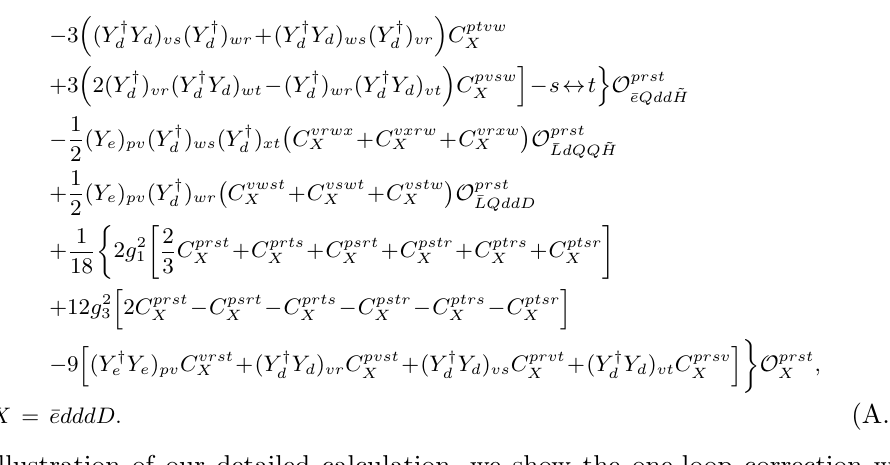
(cid:16) (cid:17) (cid:0) 3 ( Y y Y d ) vs ( Y y ) wr +( Y y Y d ) ws ( Y y ) vr C ptvw d d d d